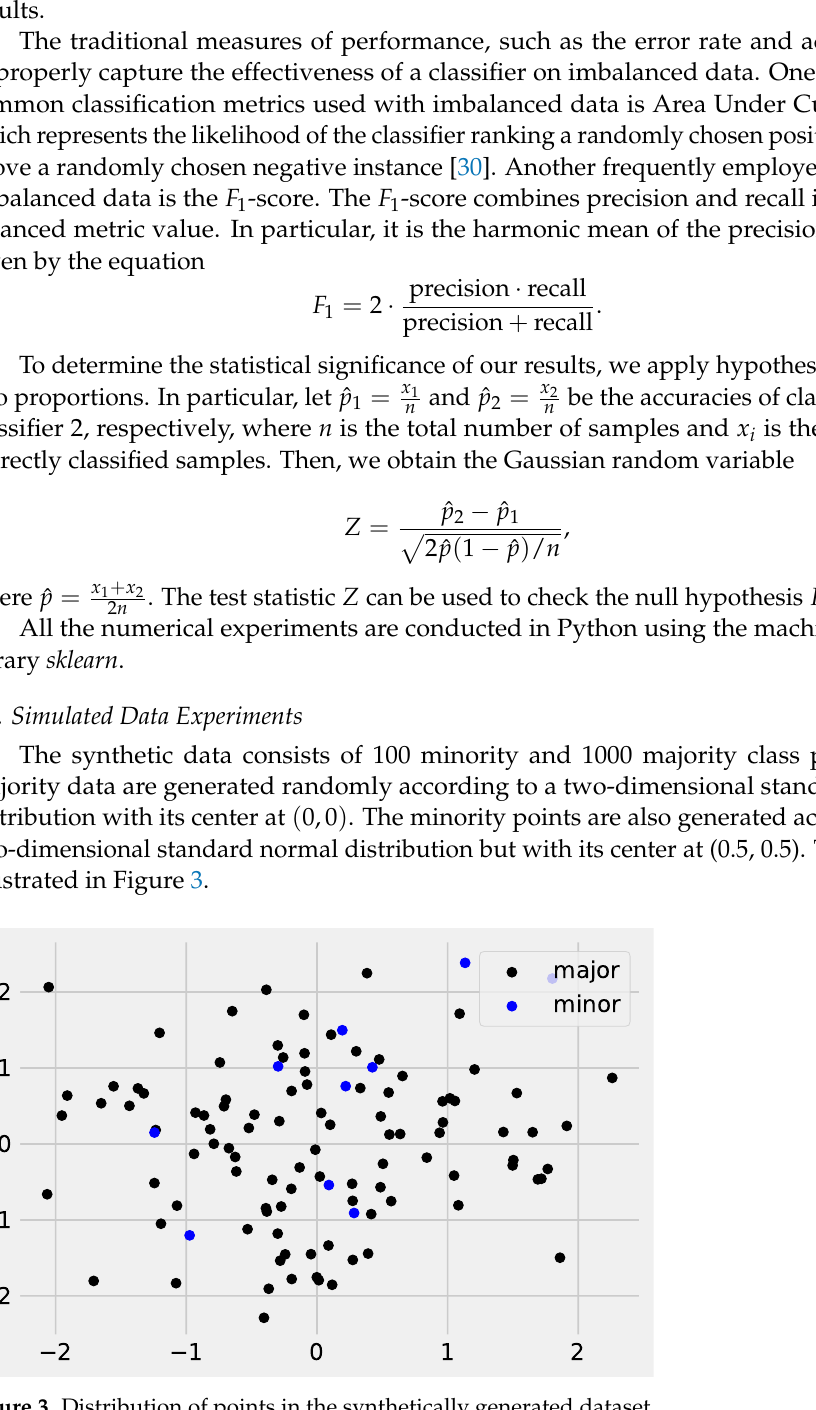
Figure 3. Distribution of points in the synthetically generated